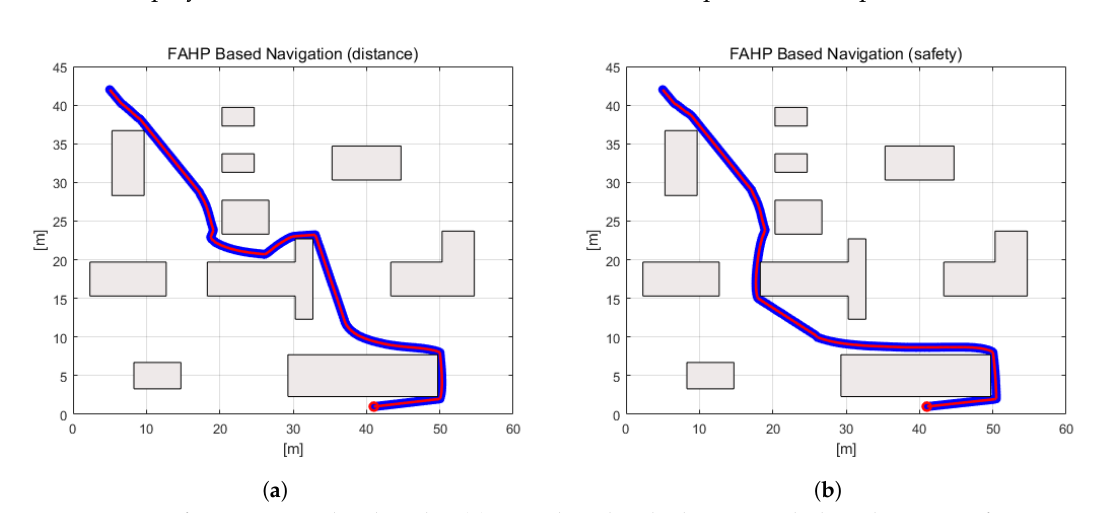
Figure 11. Safety margin under obstacles: ( a ) FAHP based path planning with short distance preference ( b ) FAHP based path planning with high safety